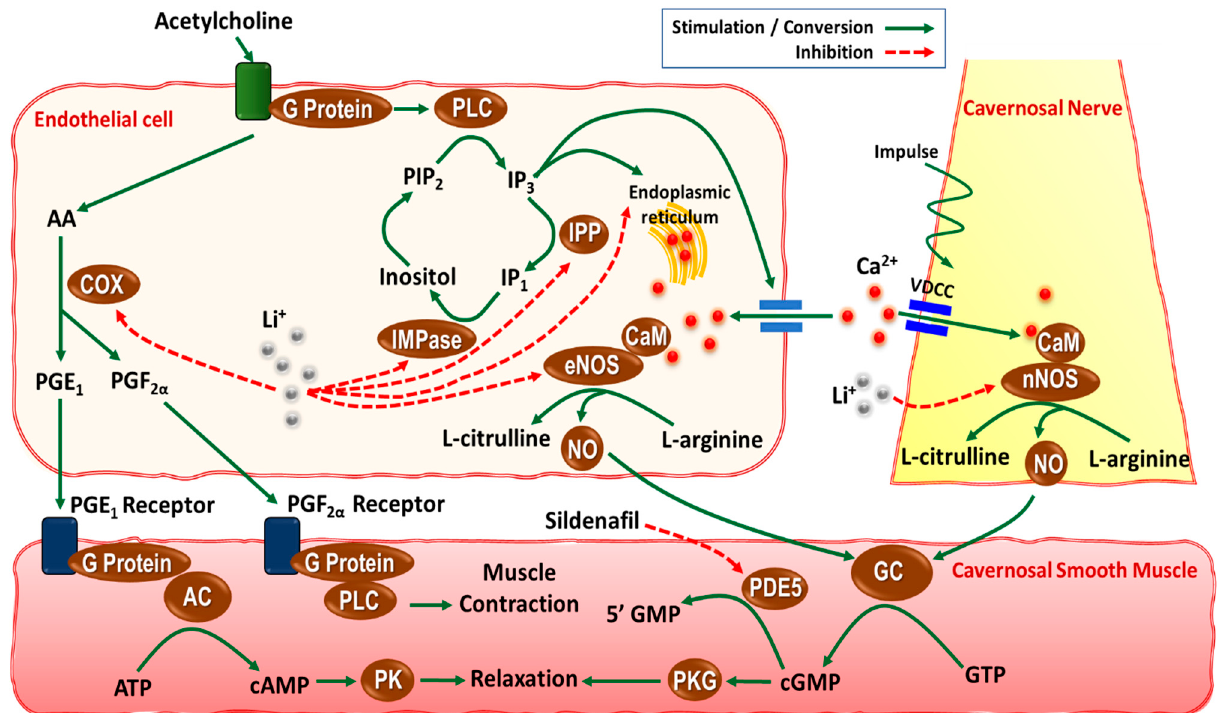
Figure 2. Schematic representation of possible mechanisms underlying the effects of lithium on neurogenic and endothelium ‐ mediated relaxation of cavernosal smooth muscle, and thereby erectile function. In endothelial cells, acetylcholine binds to the G ‐ protein ‐ coupled receptor that can activate phospholipase C (PLC) and thereby increasing the production of inositol 1,4,5 ‐ trisphosphate (IP 3 ) [92]. IP 3 releases Ca 2+ from the endoplasmic reticulum or increases Ca 2+ influx via calcium channels. Ca 2+ then binds to calmodulin and activates endothelial nitric oxide (NO) synthase (eNOS) that eventually leads to production of NO from L ‐ arginine. Lithium (Li + ) can negatively affect this pro ‐ cess through several mechanisms. It can inhibit the IP 3 production cycle via inhibition of inositol